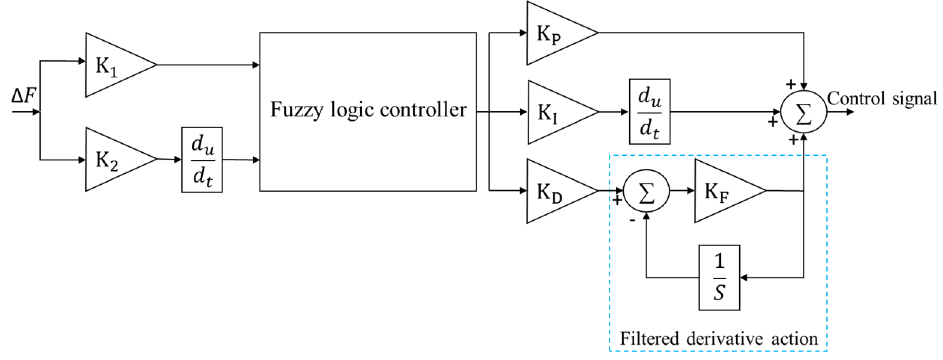
Figure 3. Structural diagram of fuzzy PIDF controller.